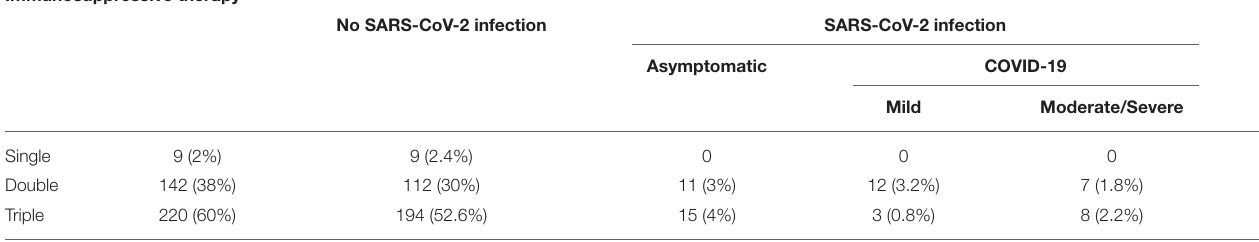
TABLE 3 | Single vs. double vs. triple immunosuppressive